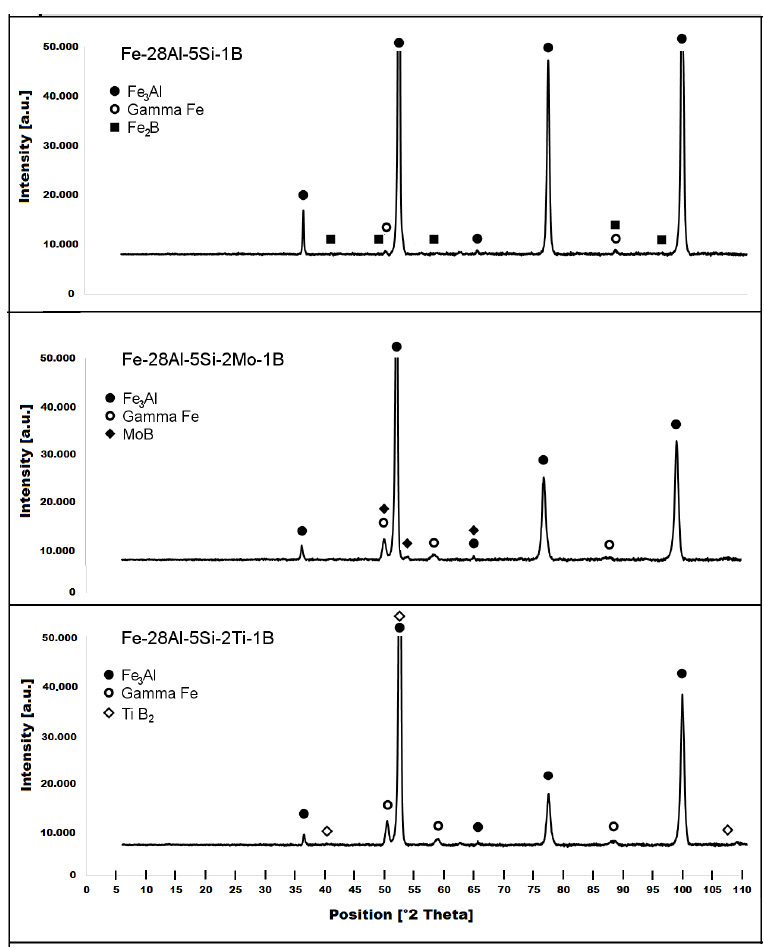
Figure 3. XRD diffractograms of investigated alloys in the as-cast state.